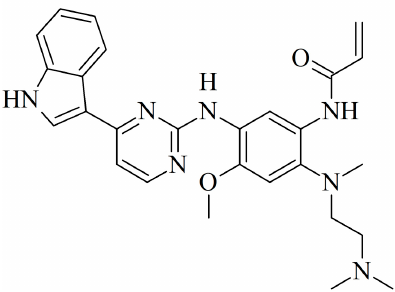
Figure 1. Structure of AZ5104, which was identified as an activator of ROR γ (nuclear receptor ROR-gamma isoform 1) by screening the L1600 kinase inhibitor library (TargetMol).